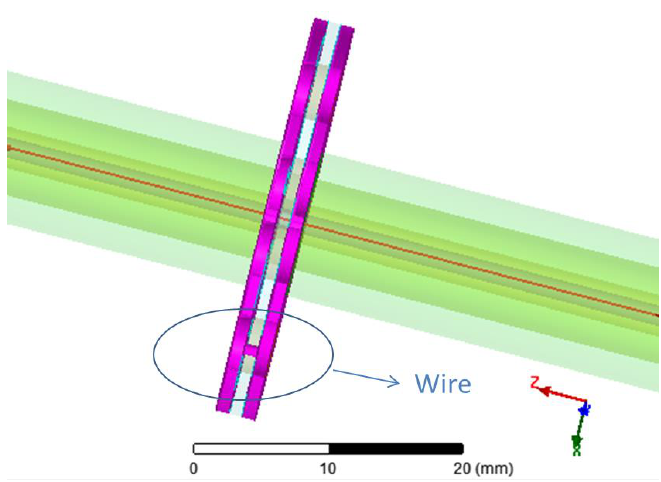
Figure A1. The sketch of the adiabatic line with cross wire across the flange.